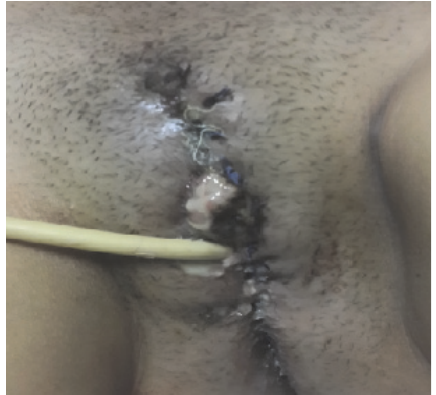
Figure 3: Postoperative appearance of Case